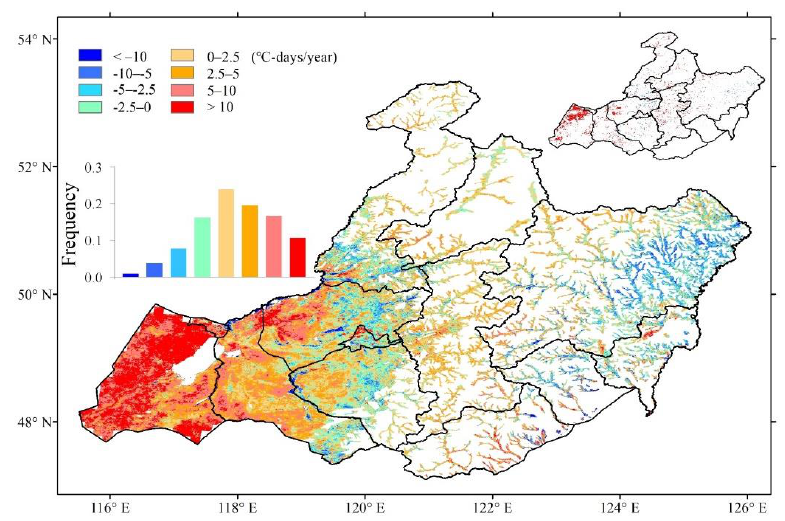
Figure 10. Spatial pattern of the temporal trends in accumulated growing degree-days require- ments (in °C - days year –1 ) between 2001 and 2015. The top-right inset indicates pixels with a significant ( p < 0.05) increase (red) or decrease (blue). The middle-left inset shows the frequency distribution of trends corresponding to the values indicated by the map legend.